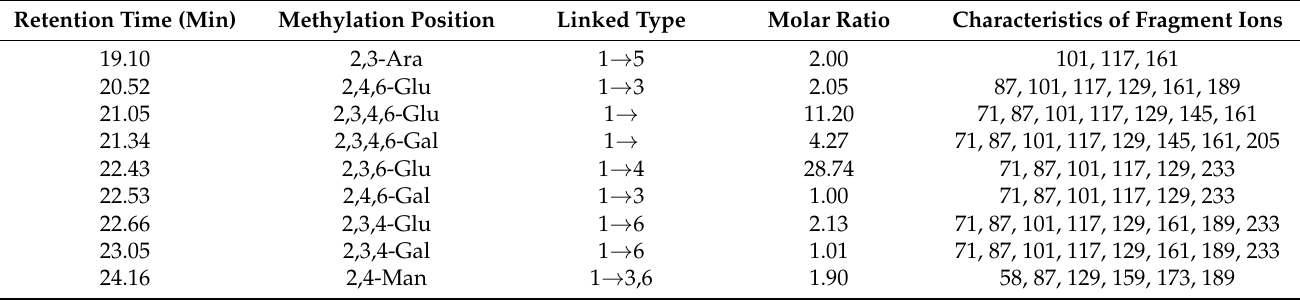
Table 1. GC–MS results of methylated LTC-1.